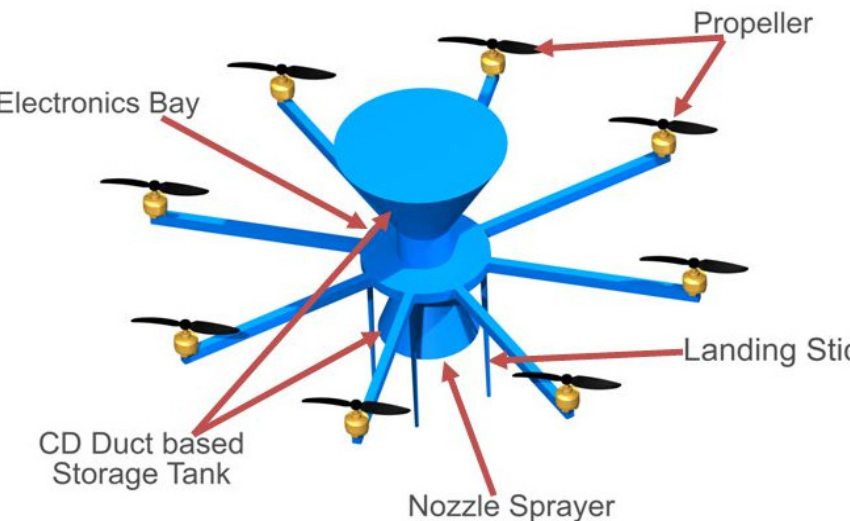
Figure 1. Conceptual design of proposed octocopter, with its components.